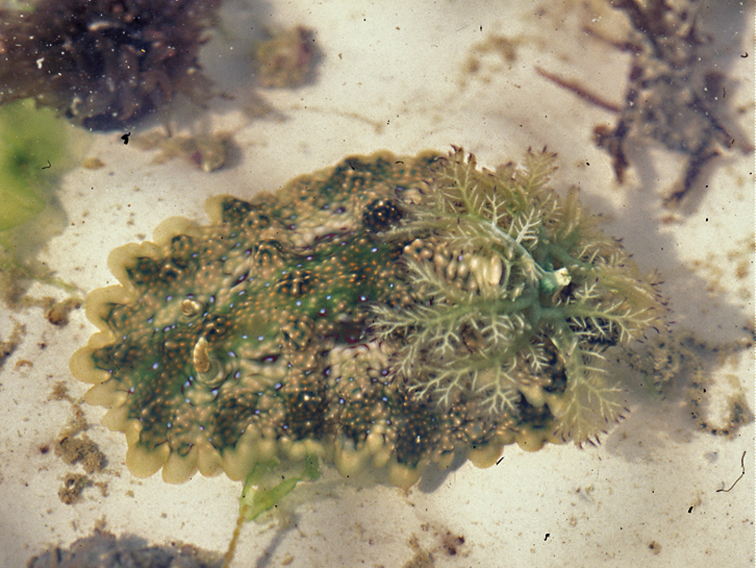
Ceratosoma miamirana, 36 mm pres., Zanzibar, photo: MD Richmond.